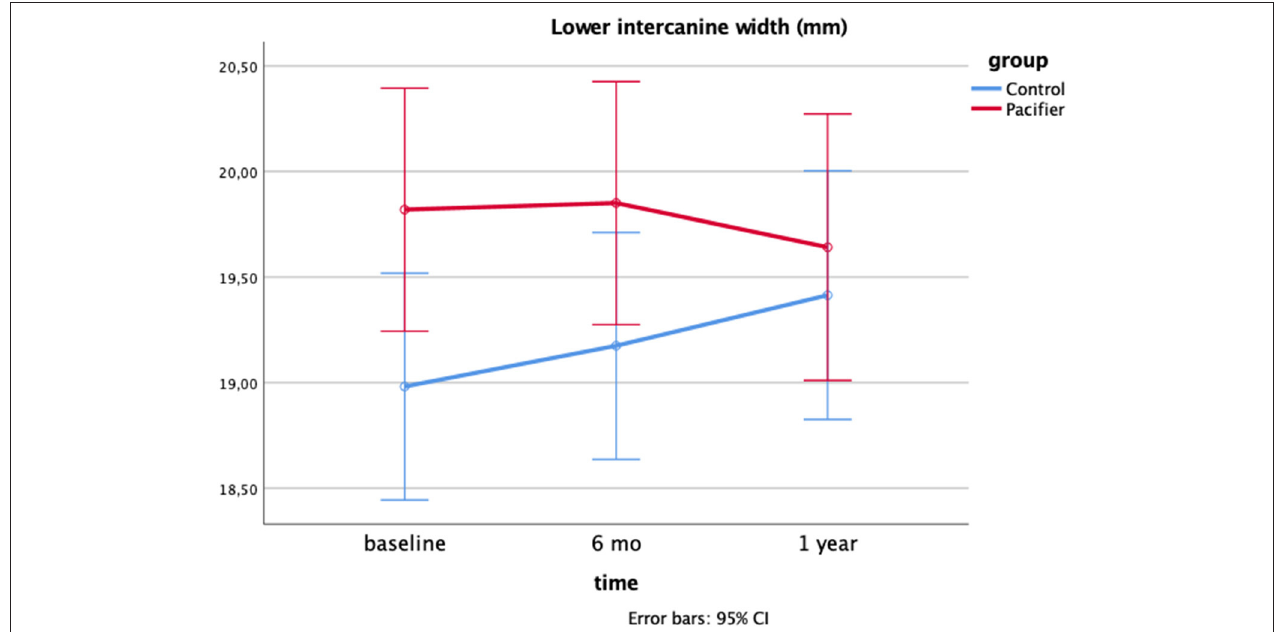
FIGURE 2 | Interaction effect time*group on the lower intercanine width after 1-year follow-up: a two-way Mixed model ( p = 0.020; eta partial squared = 0.07; power = 71%).